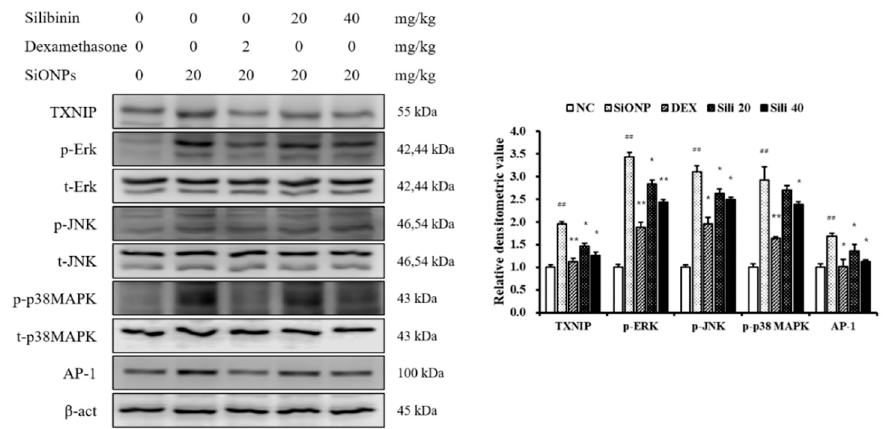
Figure 7. Effects of silibinin treatment on TXNIP, MAPK, and AP-1 expressions in the lung tissue from SiONPs-exposed mice. Protein expression was evaluated by Western blotting analysis, and densitometric value of protein expression was determined by Chemi-Doc. NC, normal control mice treated with PBS only; SiONPs, mice treated with SiONPs intranasal instillation; DEX, mice treated with dexamethasone (2 mg/kg) + SiONPs intranasal instillation; Sili 20 and 40, mice treated with silibinin (20 and 40 mg/kg, respectively) + SiONPs intranasal instillation. Data are represented as means ± SD ( n = 6). ## p < 0.01 vs. NC group, * , ** p < 0.05 and < 0.01 vs. SiONPs group, respectively.